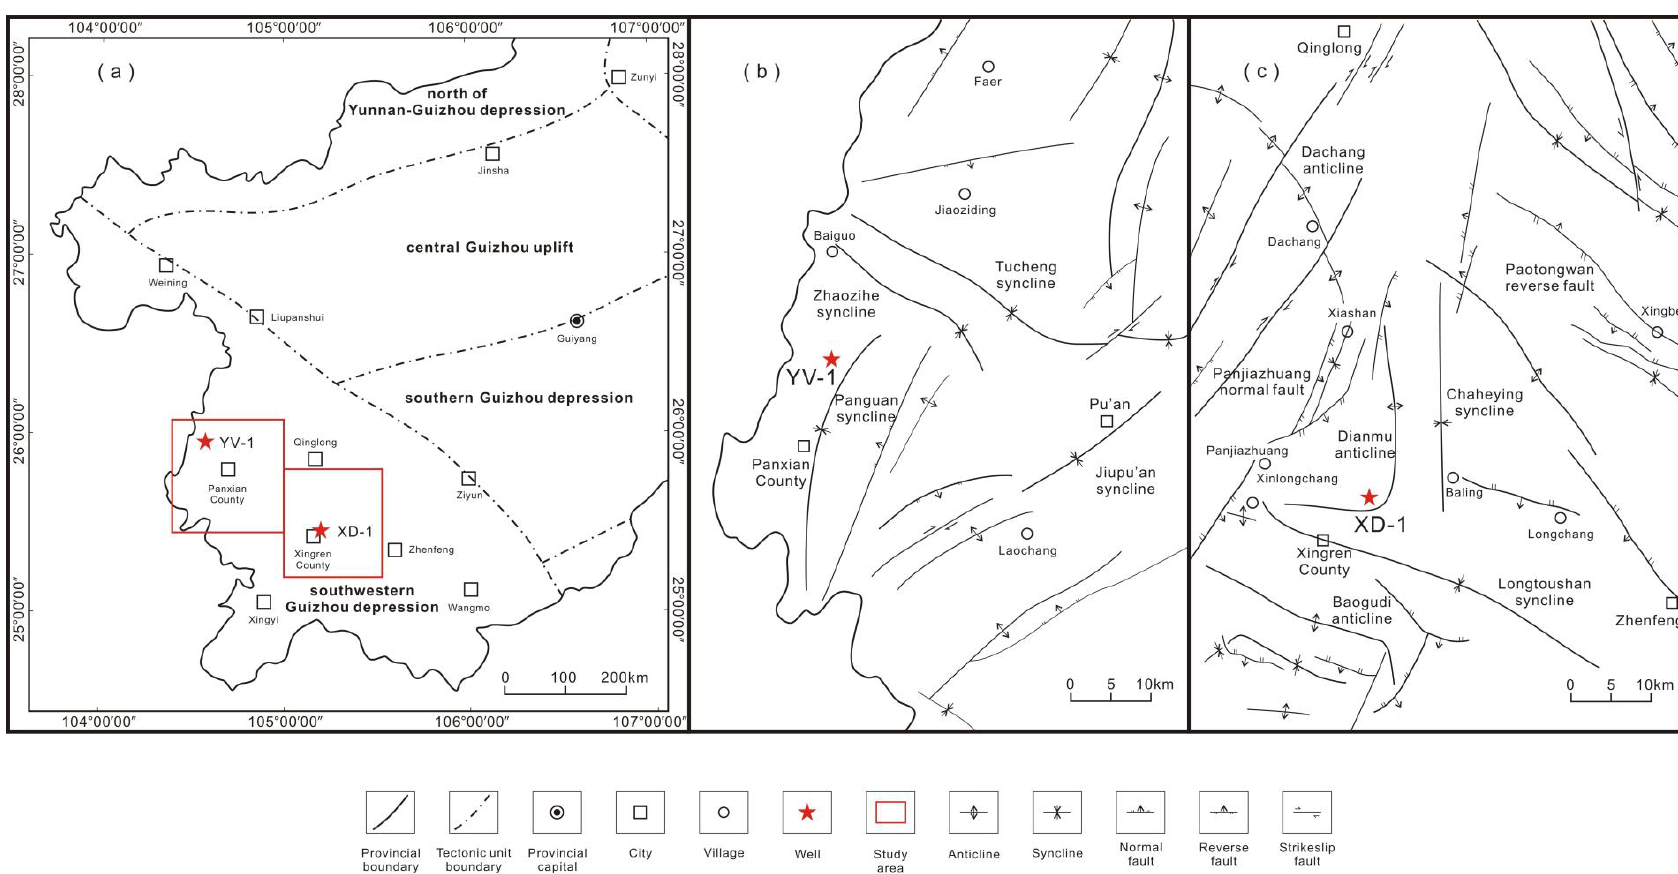
Figure 1. ( a ) Location of the study area in southwest Guizhou Province, China; ( b ) main structures in Panxian County; ( c ) main structures in Xingren